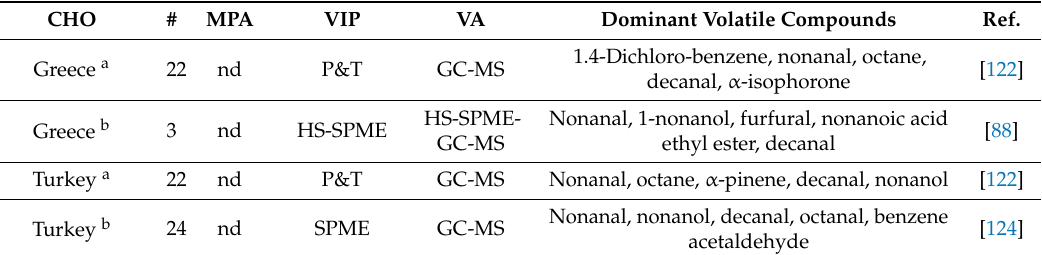
Table 14. Main volatiles of pine honey and honeydew, with reference to the country of origin, number of samples, isolation and analysis procedures and five main volatile components. Unless otherwise specified, the honeybee type was A. mellifera